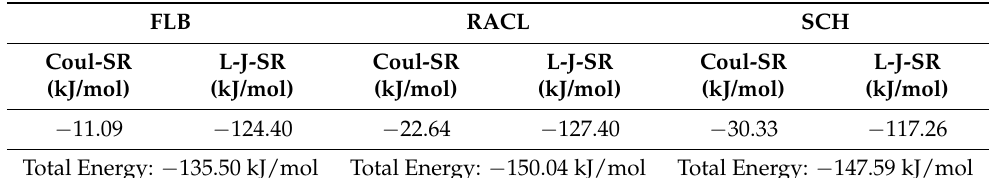
Table 3. Total interaction energies (calculated as the sum between Coulombic and Lennard-Jones interactions) for the three ligands docked at D2DR’s top position.